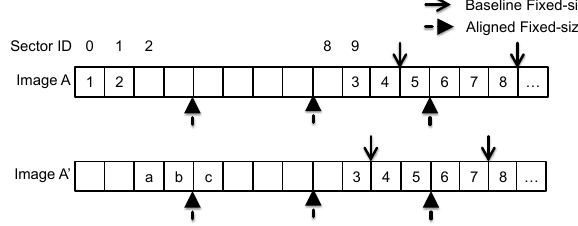
Figure 4: Comparison between baseline fixed-size chunking and aligned fixed-size chunking